Question: Which visualization type does this figure use?
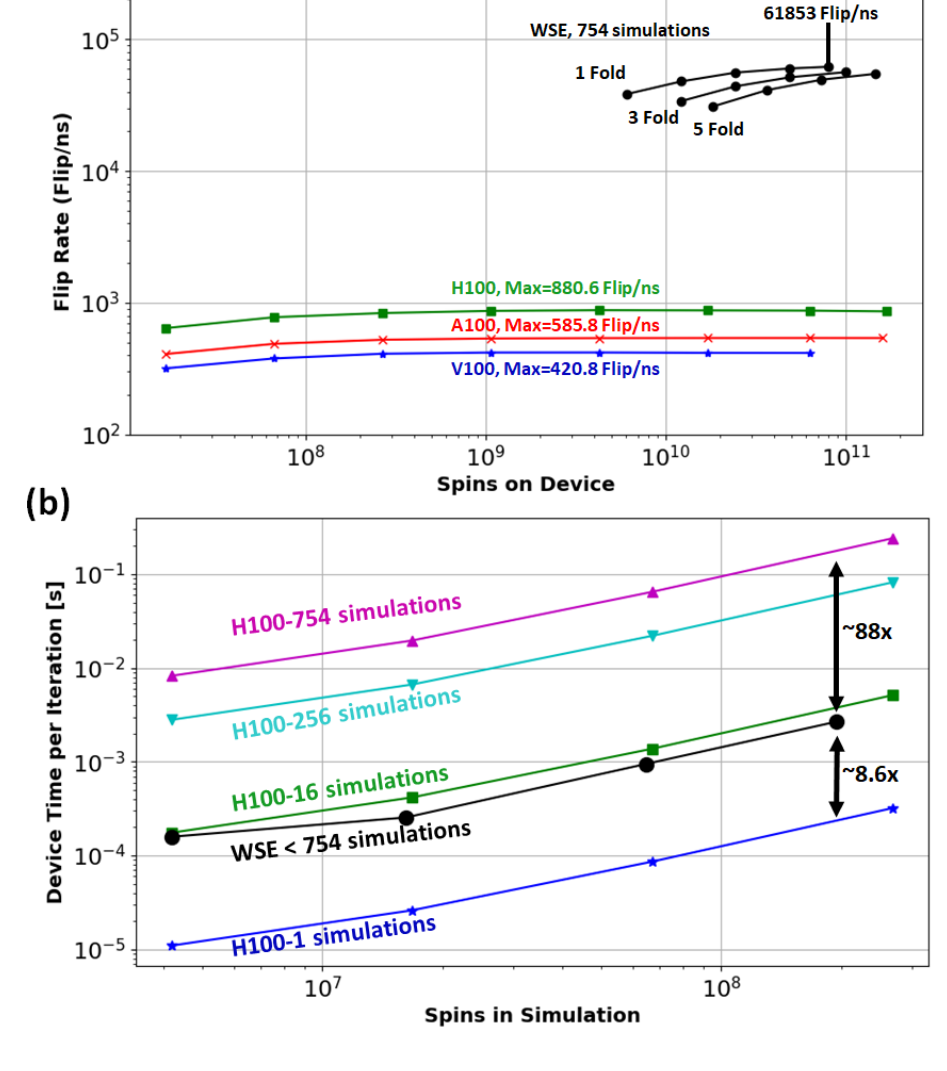
Answer: line